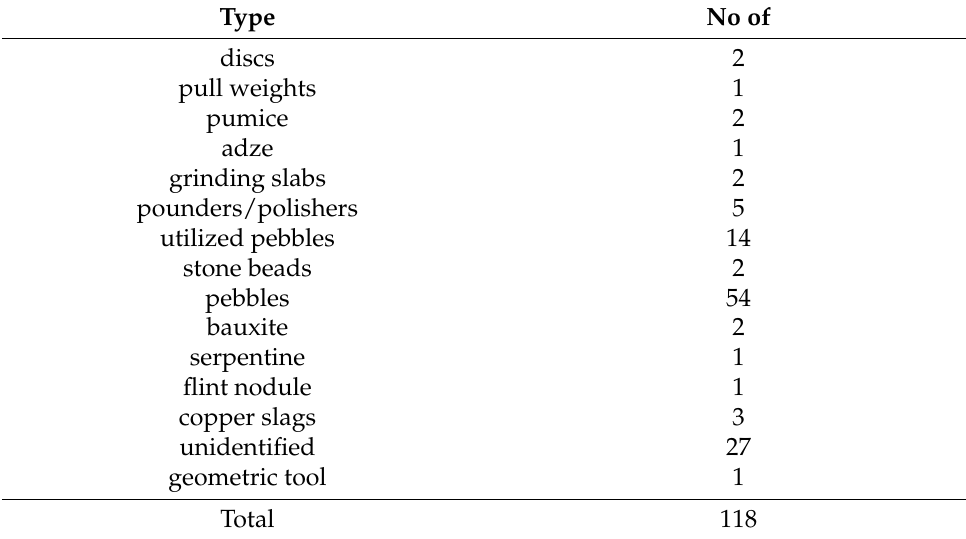
Table 1. Typology of the assemblage recovered during the Table 1 . Typology of the assemblage recovered during the surveys .